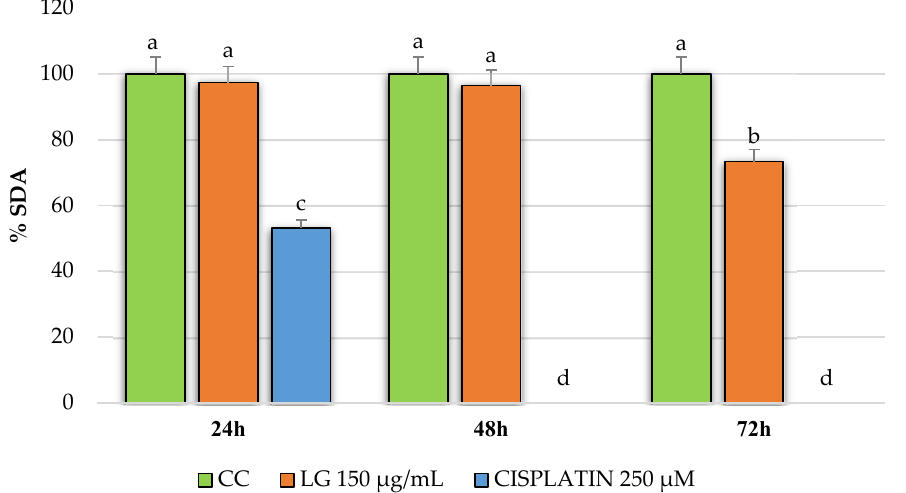
Figure 5. Antiproliferative potential of PRE of L. graveolens on MCF-7 breast cancer cells expressed as a percentage of succinate dehydrogenase activity (%SDA). Values with different letters are statistically different ( p ≤ 0.05). The results are expressed as means (n = 3) ± standard deviation (bars).